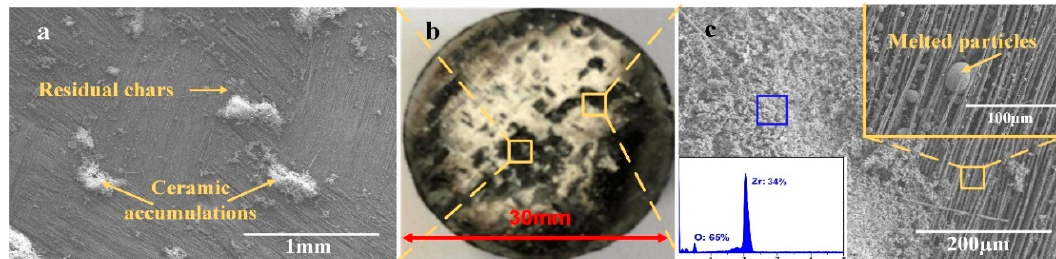
Figure 6. The ablated morphology of the 2C-C–Ph composite at different region: ( a ) The area without ceramic accumulations, ( b ) the 2C-C–Ph composite, and ( c ) the edge area of ceramic accumulations.